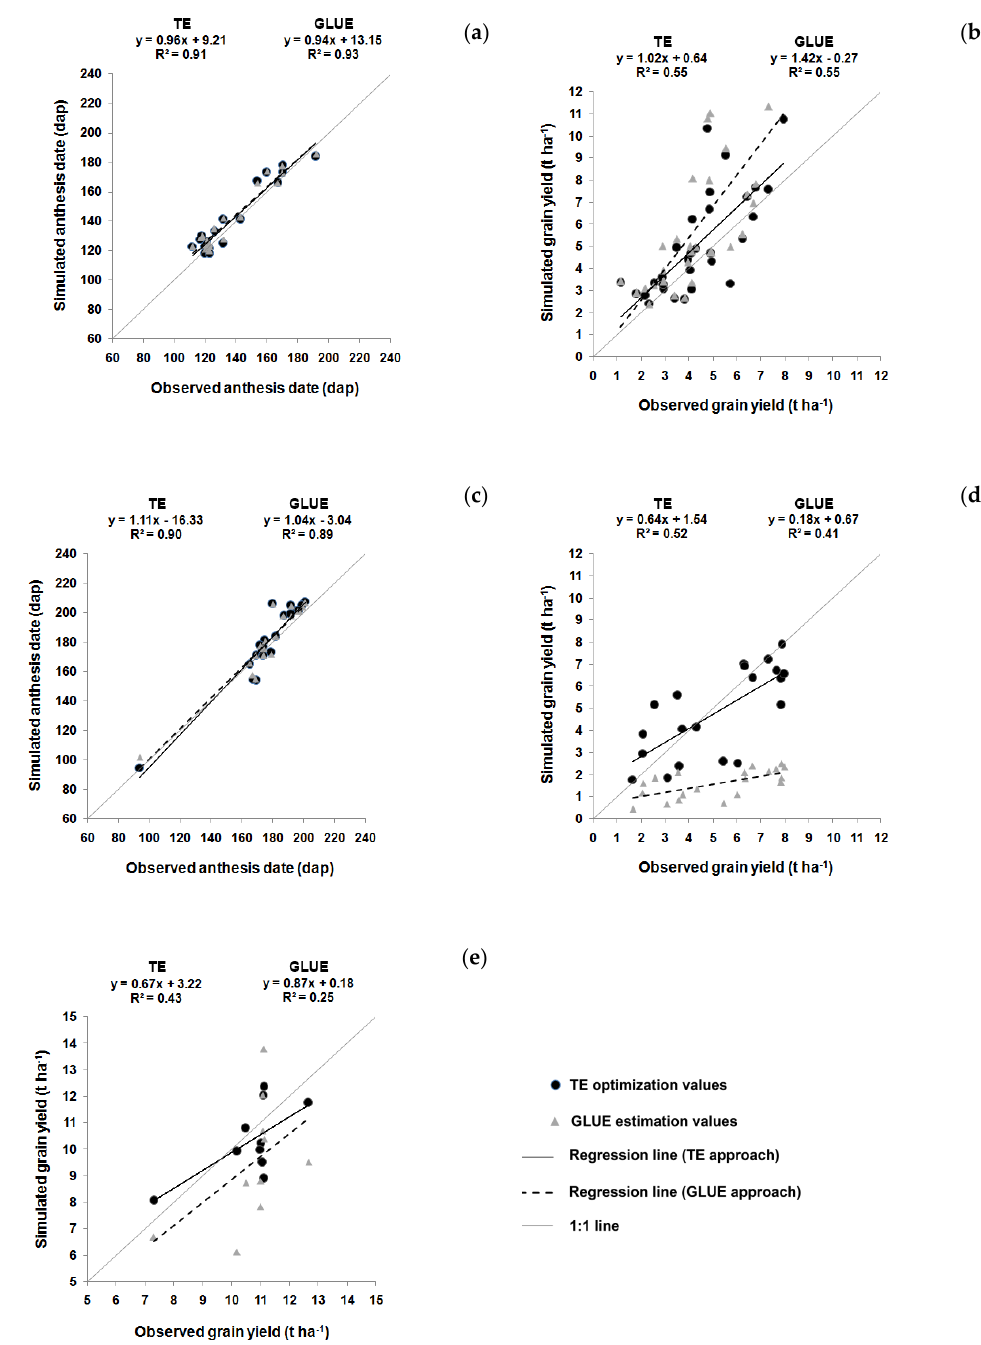
Figure 3. Evaluation results for anthesis date ( a ) and grain yield ( b ) of durum wheat (Iride cv), anthesis date ( c ) and grain yield ( d ) of common wheat (Bologna cv), and grain yield of maize (Eleonora hybrid) ( e ) with TE and GLUE methods.